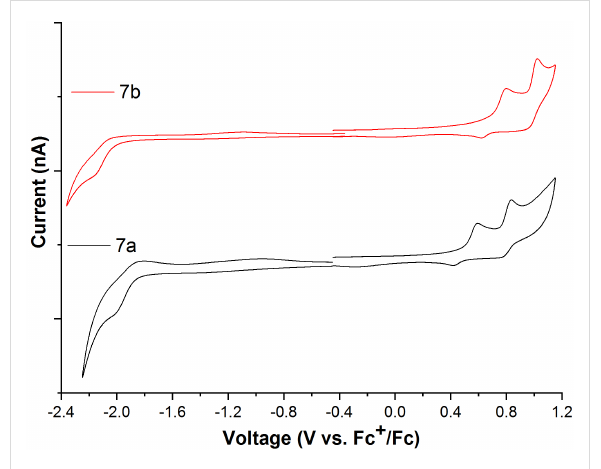
Figure 2: Cyclic voltammograms of compounds 7a and 7b in dichloro- methane under argon atmosphere at room temperature.